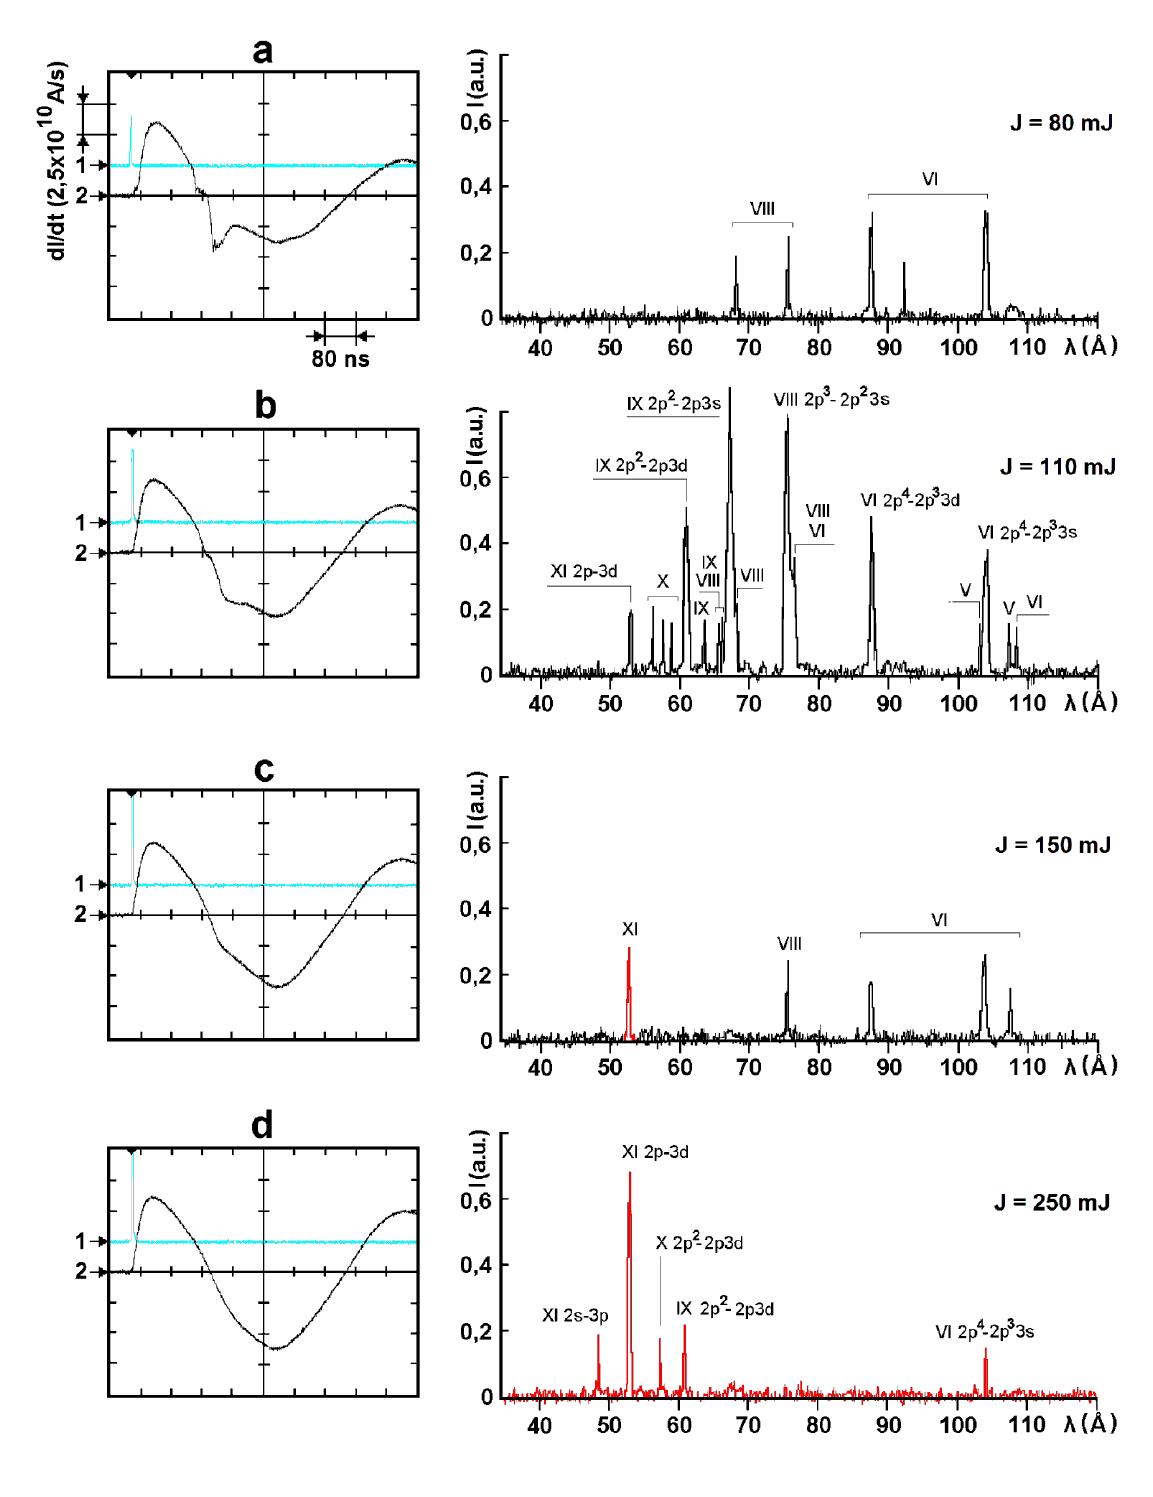
Fig. 2. Oscillograms of the discharge current derivative (at the left) and emission spectra of the Al plasma for U = 6 kV and different J (at the right). (1) laser pulse; (2) current derivative. The emission spectra of the discharge and laser plasma are shown by black and red curves,